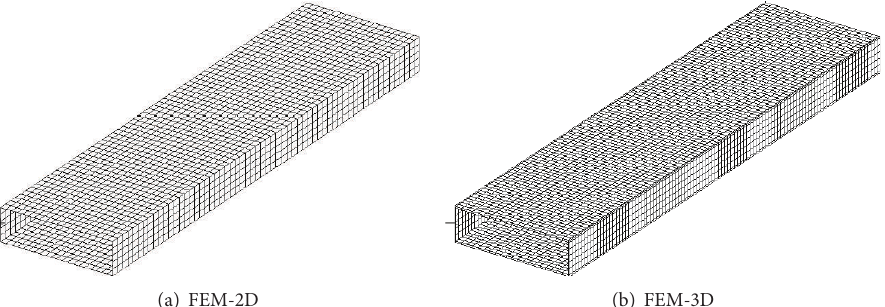
Figure 18: Mesh discretization for the FEM-2D and FEM-3D MSC Nastran © models.